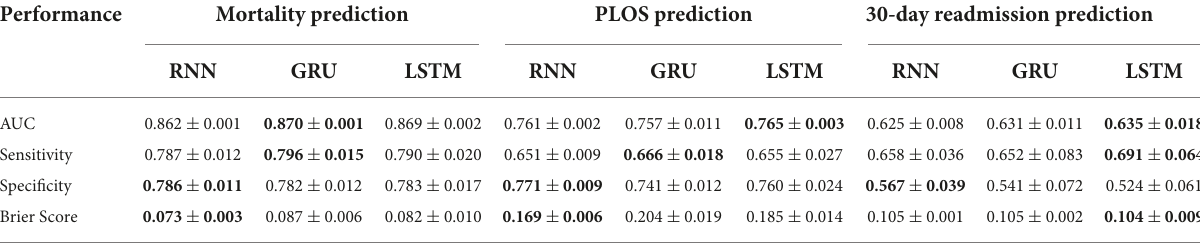
TABLE 2 Model performance in predicting hospital mortality, PLOS, and 30-day readmission of patients in ICU. Performance Mortality prediction PLOS prediction 30-day readmission prediction RNN